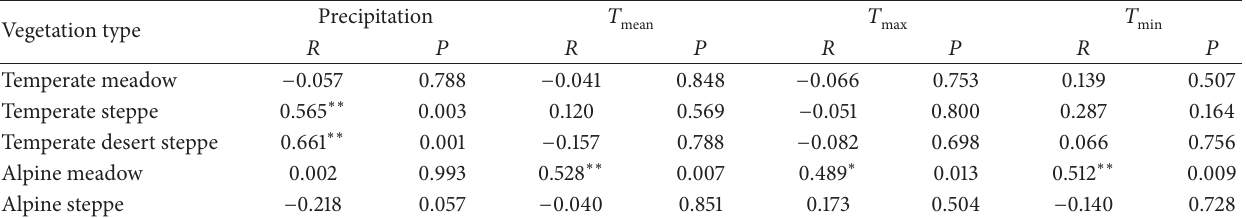
Table 1: Correlation coefficients ( 𝑅 ) and two-tailed significance test values ( 𝑃 ) between growing season NDVI and precipitation or temperature for different grassland